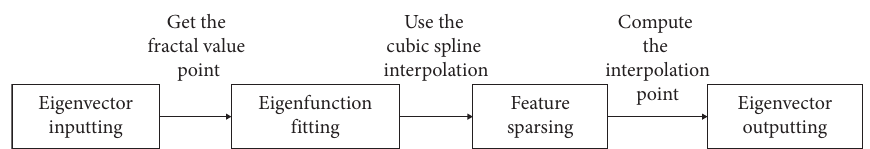
Figure 7: Process of the cubic spline interpolation pooling.